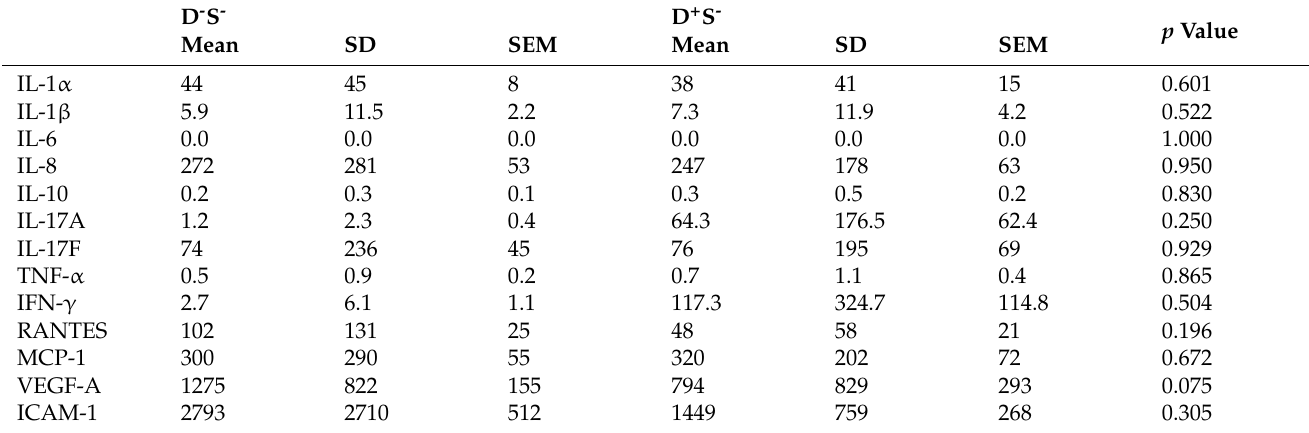
Table 1. Tear fluid secreted factors levels in subjects with discomfort but no signs.